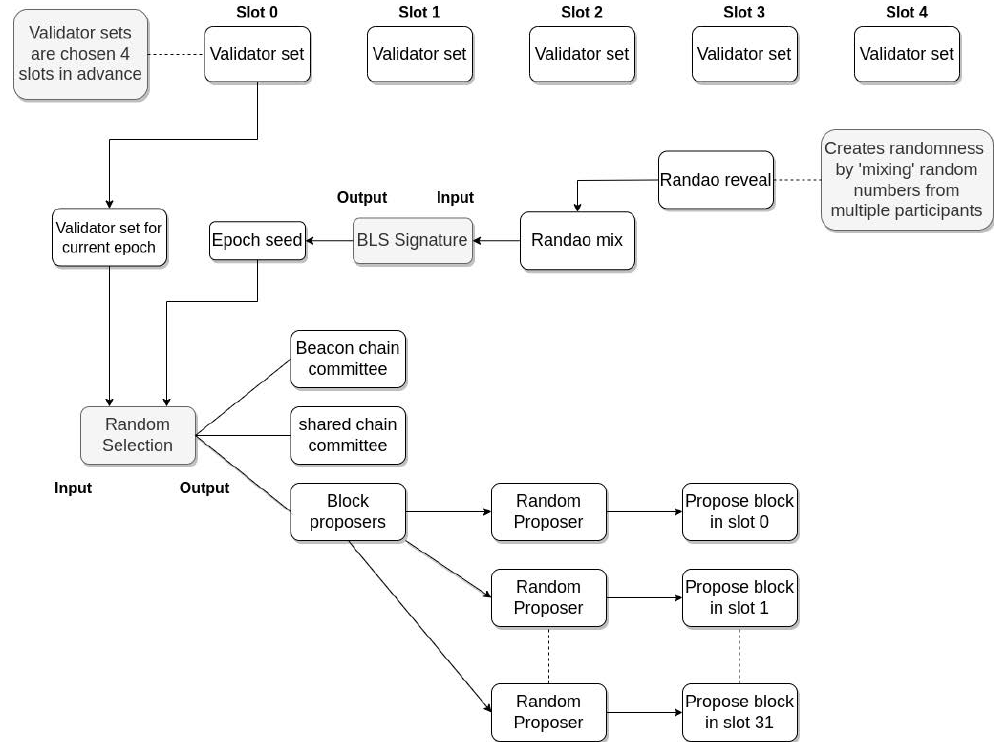
Figure 7. Ethereum PoS